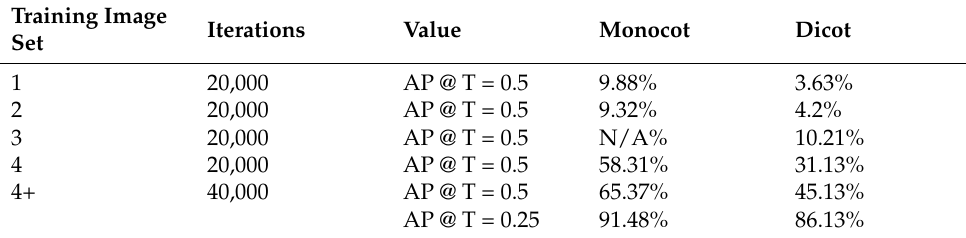
Figure 11. Dicot detection result from the YOLOv3 network training on Training Image Set 4+, using the Gilbreth cluster. Table 8. Summary of the results from the network